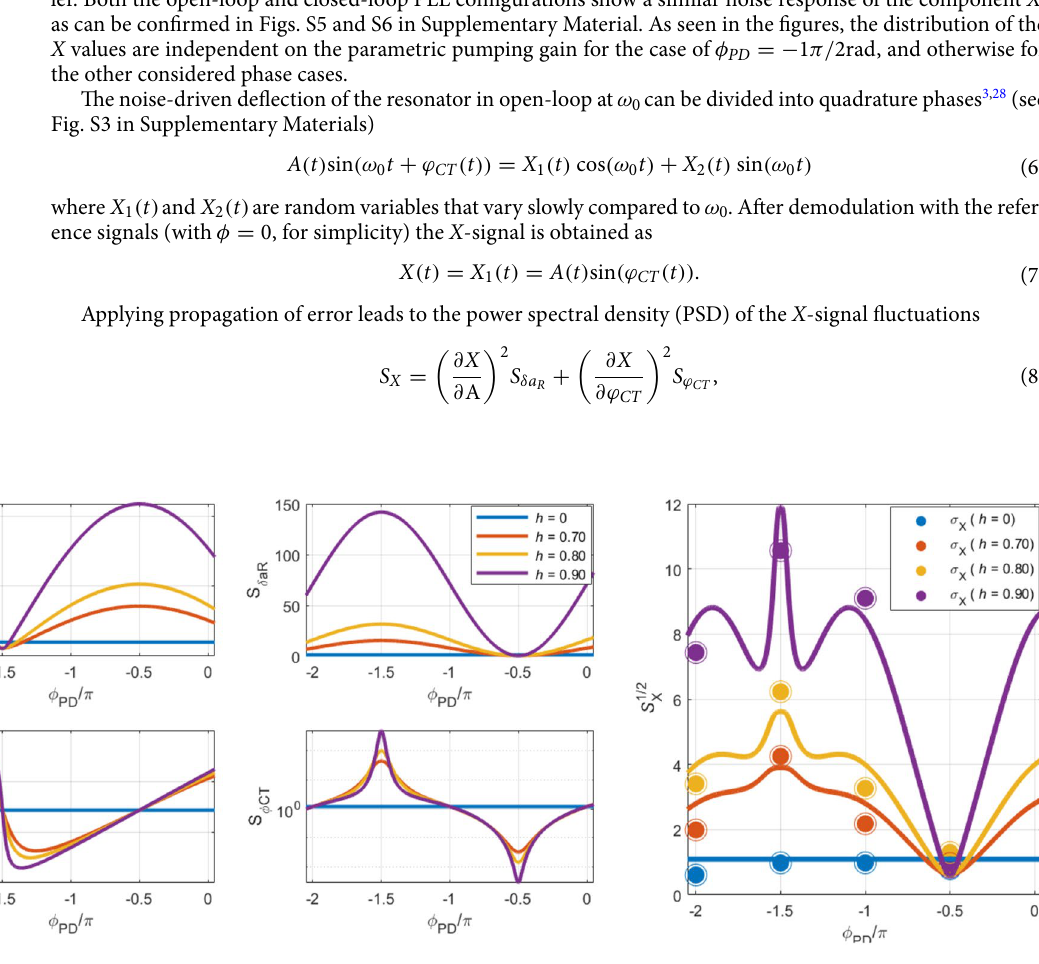
pumped resonator. In the next section, the fluctuation of X -signal measured in open-loop is modelled and used to explain the frequency noise observed in the closed-loop PLL. Power Spectral Density of the X ‑signal in open‑loop and frequency noise in the closed‑loop PLL. The fluctuations in the X -signal (measured and modelled in open-loop—Figs. 4 and 5) can be readily translated to the frequency noise observed in the closed-loop PLL (discussed in Fig. 3) by assuming that a single value of the error component X in the PLL determines a univocal output value of frequency from the PI-control- ler. Both the open-loop and closed-loop PLL configurations show a similar noise response of the component X, as can be confirmed in Figs. S5 and S6 in Supplementary Material. As seen in the figures, the distribution of the X values are independent on the parametric pumping gain for the case of φ PD = − 1 π/ 2rad , and otherwise for the other considered phase cases. The noise-driven deflection of the resonator in open-loop at ω 0 can be divided into quadrature phases 3,28 (see Fig. S3 in Supplementary Materials)